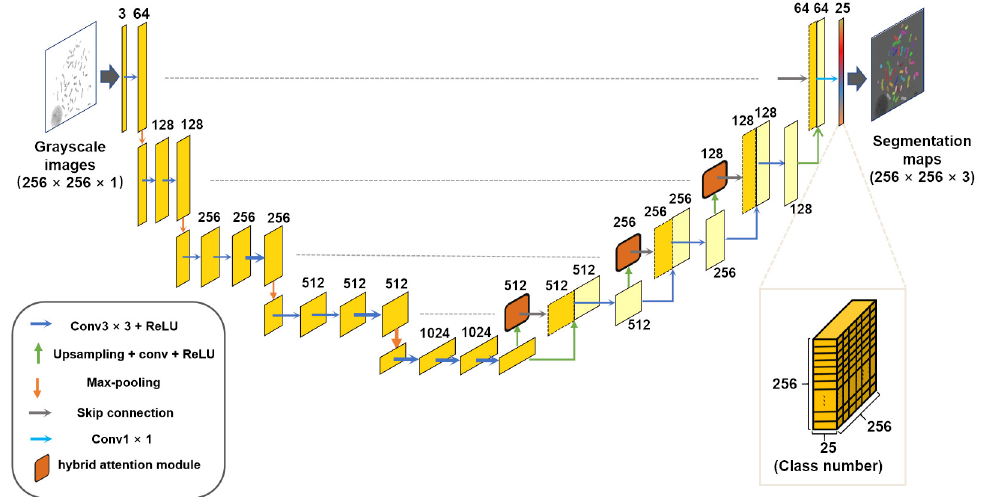
Figure 3. ChroSegNet network structure